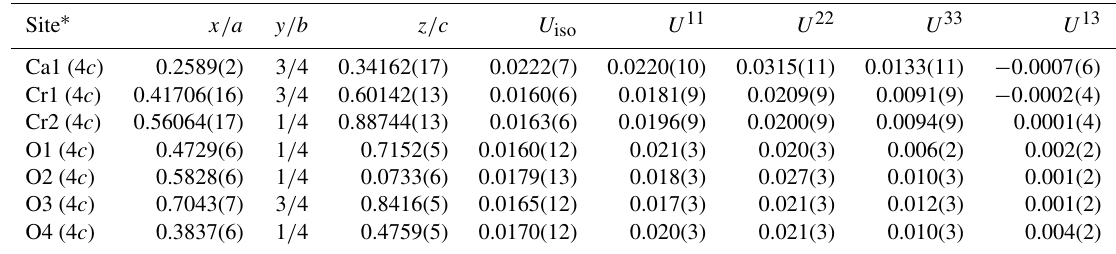
Table 5. Fractional atomic coordinates and displacement parameters (Å 2 ) for ellinaite (Hatrurim Basin).